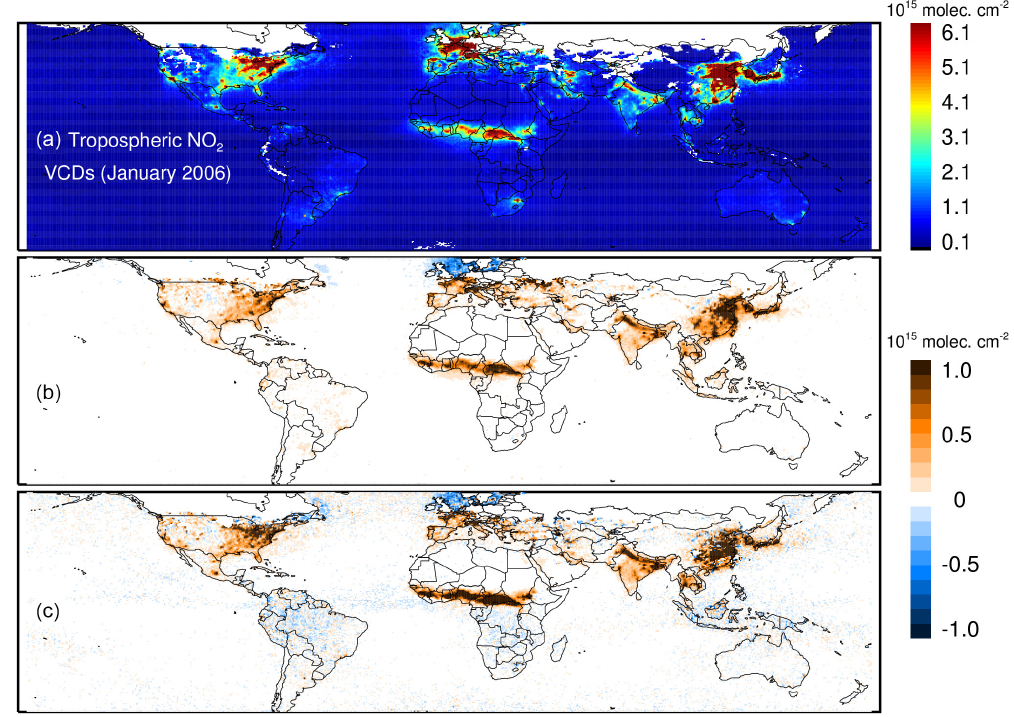
Figure 18. (a) Monthly mean gridded (0 . 5 ◦ latitude × 0 . 5 ◦ longitude) OMI NO 2 tropospheric VCDs for January 2006 retrieved using the GLER and O 2 -O 2 cloud products. (b) Change in tropospheric VCDs due to the change in surface reflectivity for NO 2 retrievals alone. (c) Change in tropospheric VCDs due to the change in surface reflectivity for both NO 2 and cloud